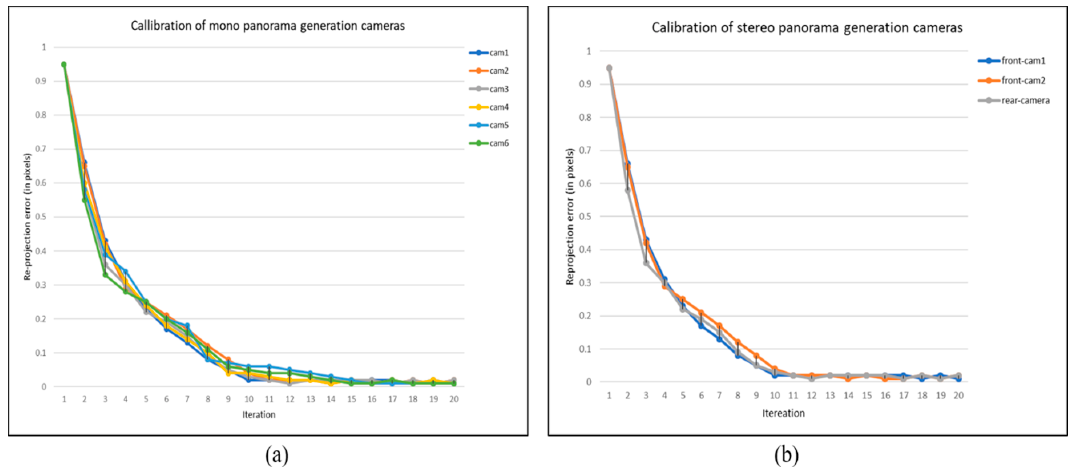
Figure 4. The optimization of camera parameter. ( a ) Reprojection error analysis of mono cameras, ( b ) Reprojection error analysis of stereo cameras.